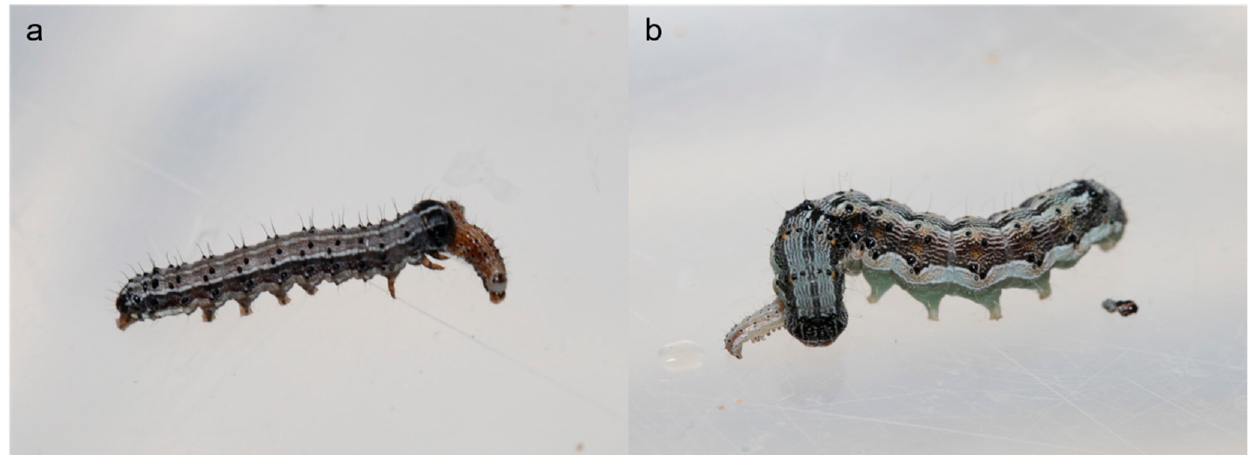
Figure 1. Photographs to show the bidirectional predation activity between Spodoptera frugiperda (FAW) and Helicoverpa armigera (CBW) larvae. ( a ) Sixth-instar larva of FAW preying on CBW. ( b ) Sixth-instar larva of CBW preying on FAW. Table 2. Logistic regression describing the proportion of sixth-instar predator larvae (